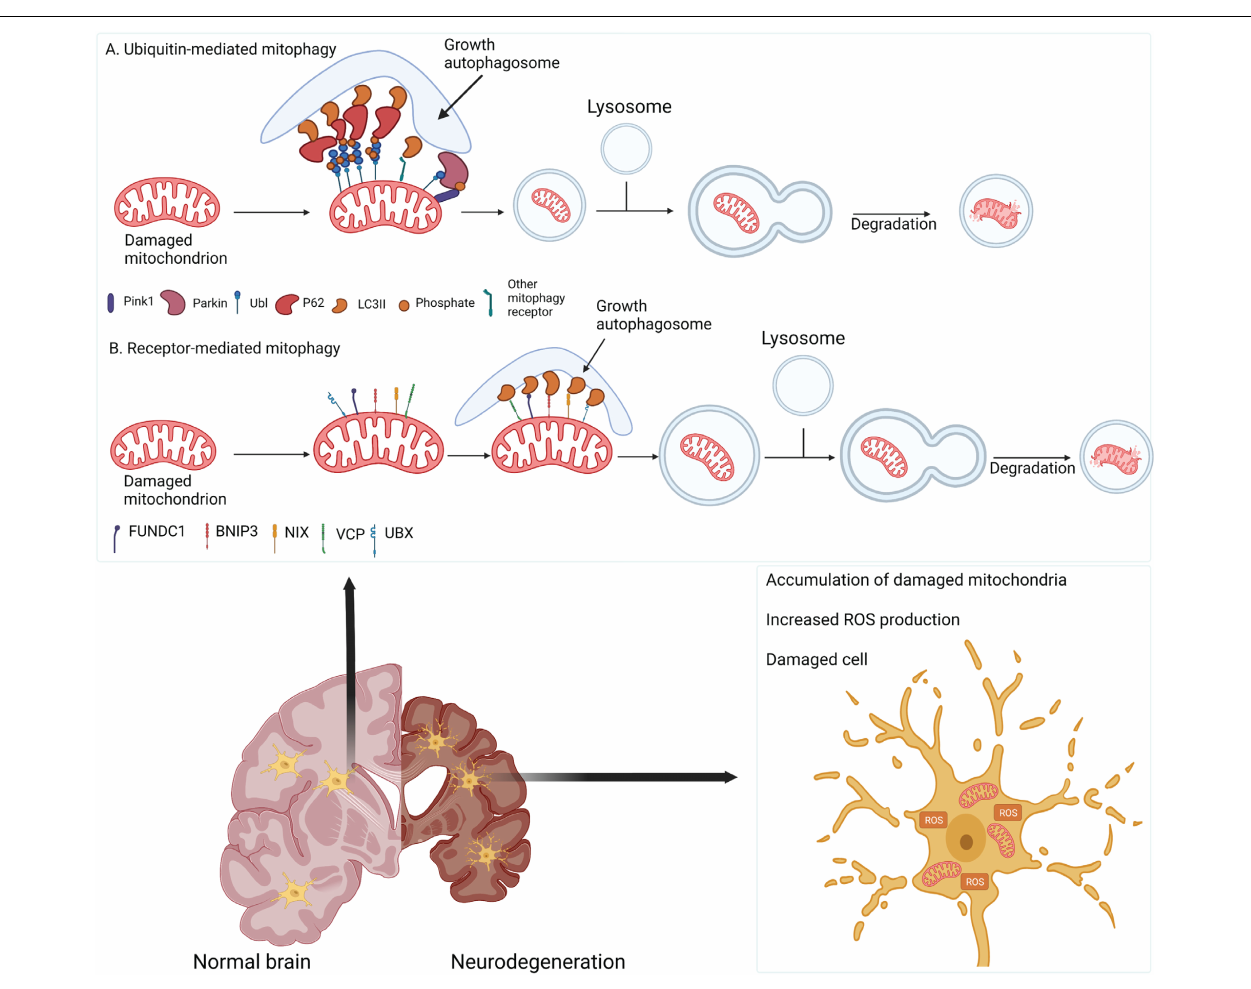
FIGURE 3 | Damaged mitochondria are cleared by mitophagy. (A) Depolarized mitochondria retain PINK1 and Parkin to ubiquitinate OMM proteins, recruiting adaptor proteins (e.g., p62) to form autophagosomes that fuse with lysosomes for degradation. (B) In parallel, mitophagy can be mediated by receptor proteins